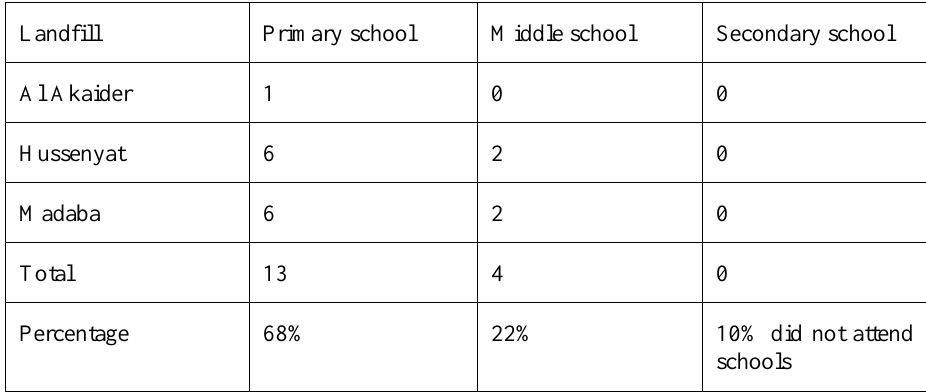
Table 4: Education level of waste